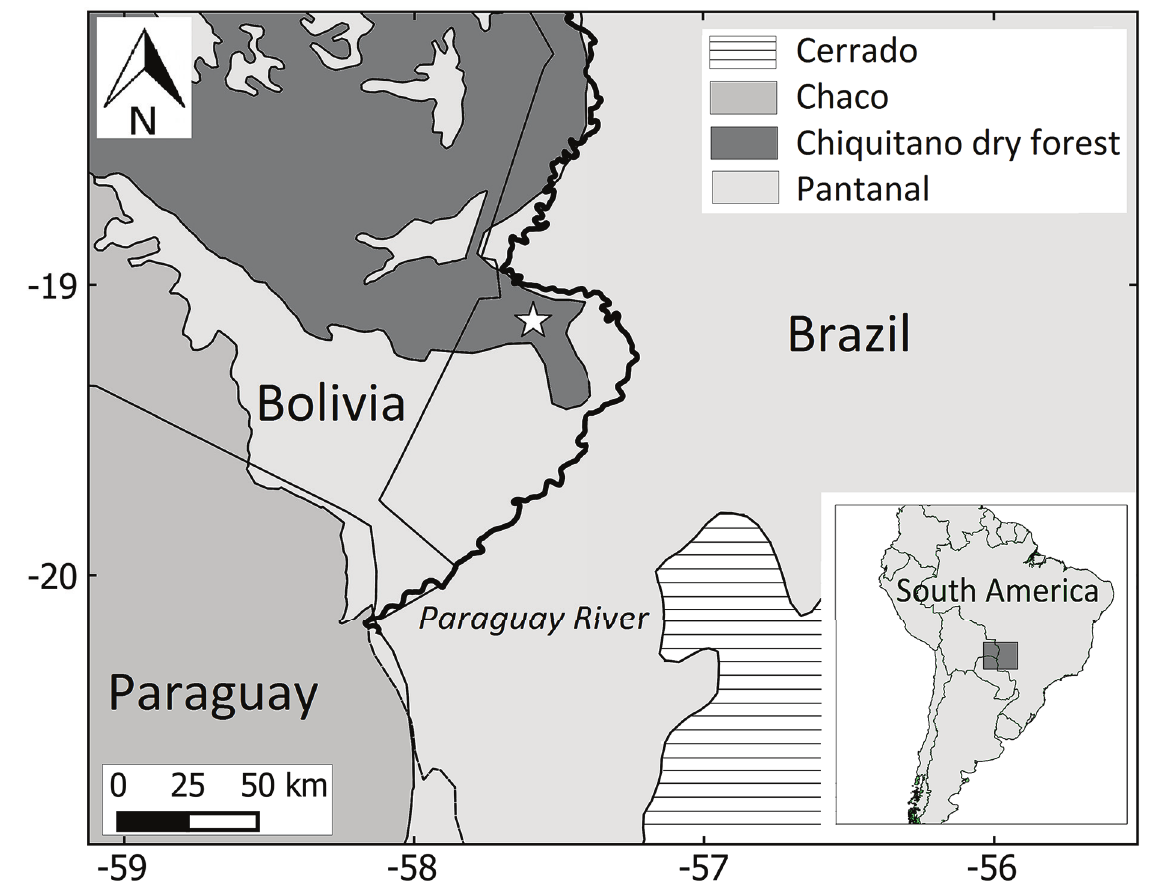
Figure 1 - The Maciço do Urucum (star) in western Brazil, and ecoregion according to Olson et al.